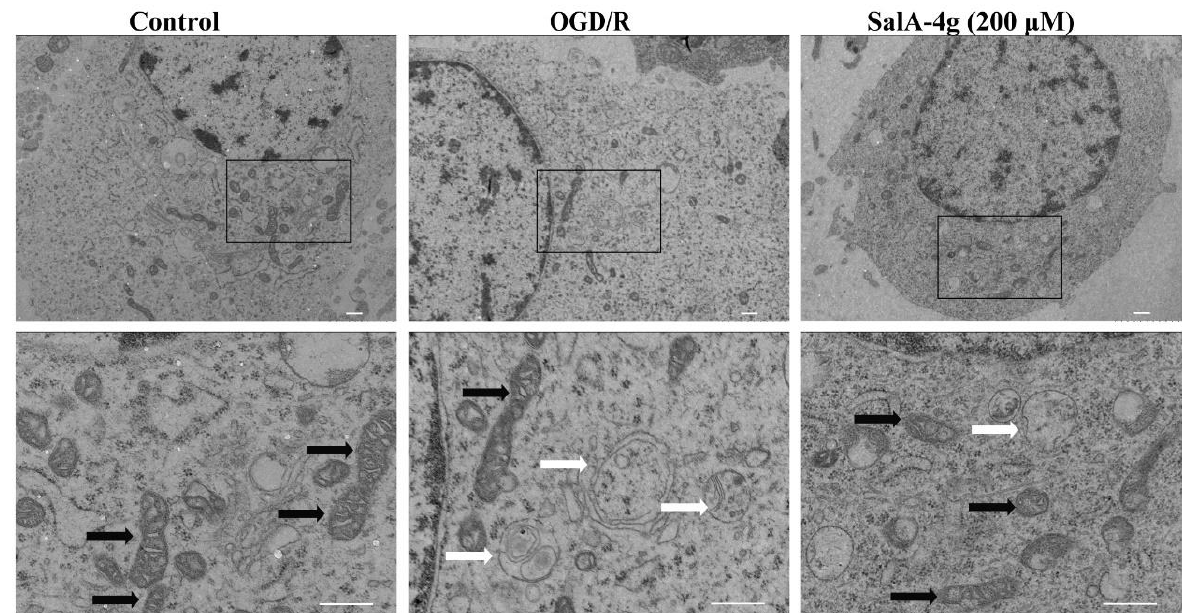
Figure 3. SalA-4g stabilizes the mitochondrial structure in cortical neurons under OGD/R stress. Representative TEM images of control cells, cells exposed to 2.5 h of OGD and 24 h of reoxygenation alone, and cells treated with 200 µ M SalA-4g during OGD/R period. White arrows indicate damaged mitochondria and black arrows indicate healthy mitochondria. Scale bar, 0.5 µ m.